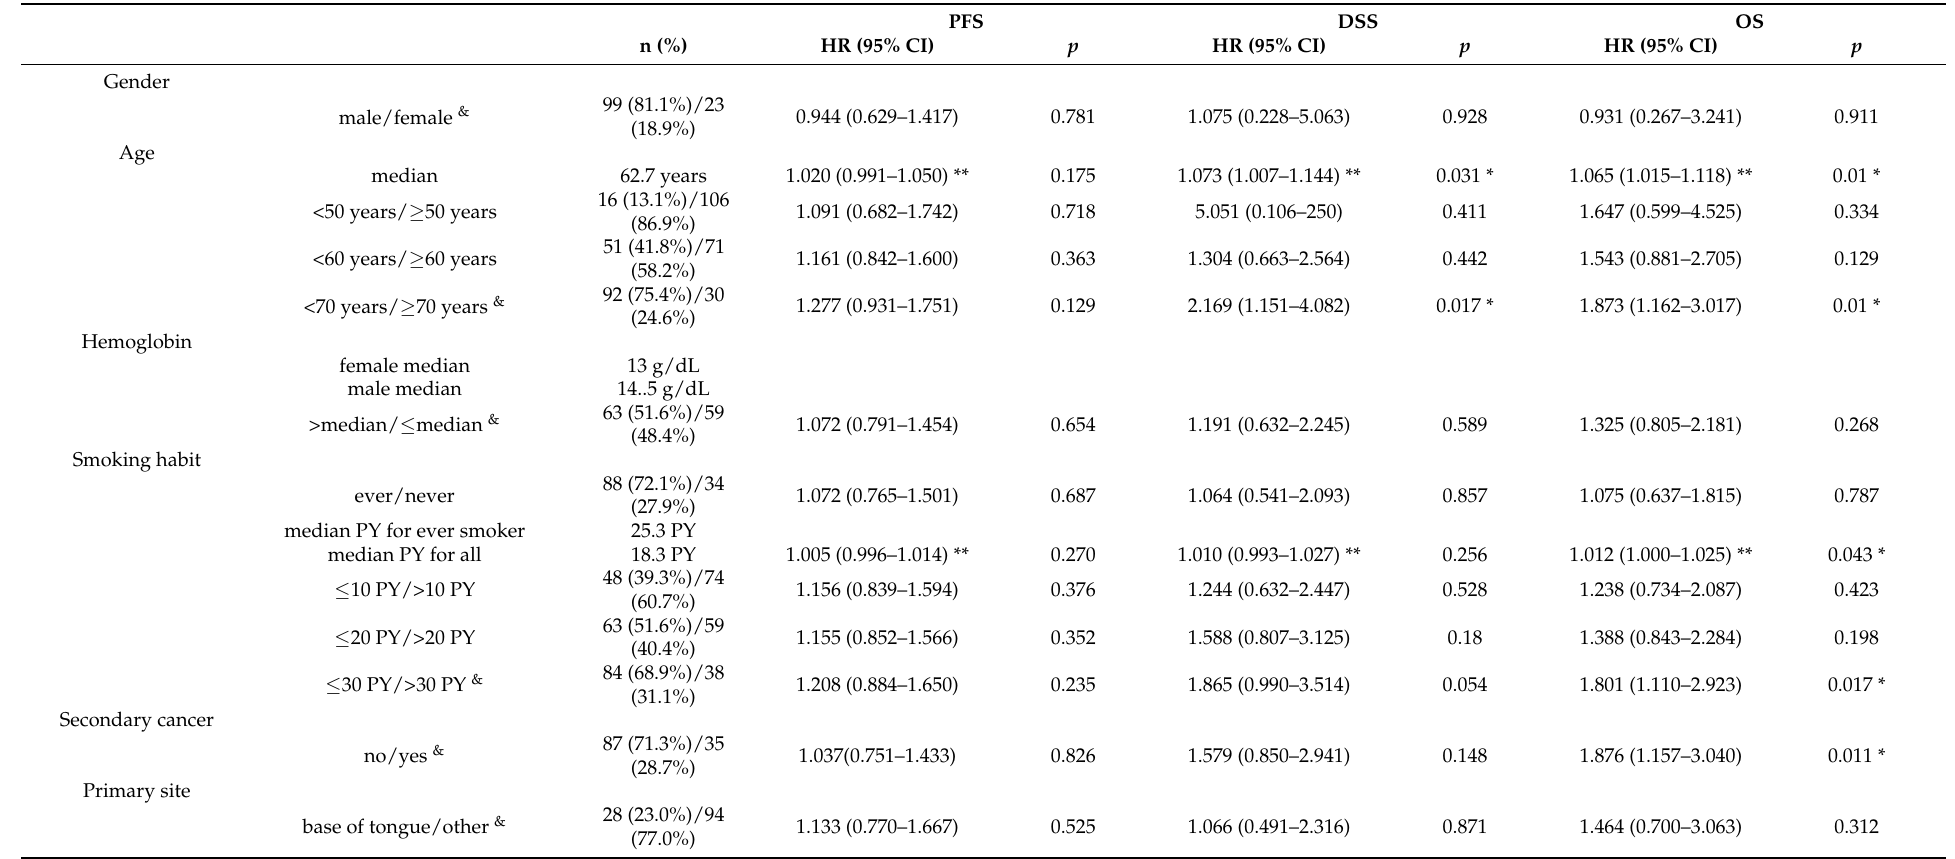
Table 1. Patient characteristics and univariate analysis with hazard ratios of the possible prognostic factors. If not indicated, the first covariate was reference (HR =